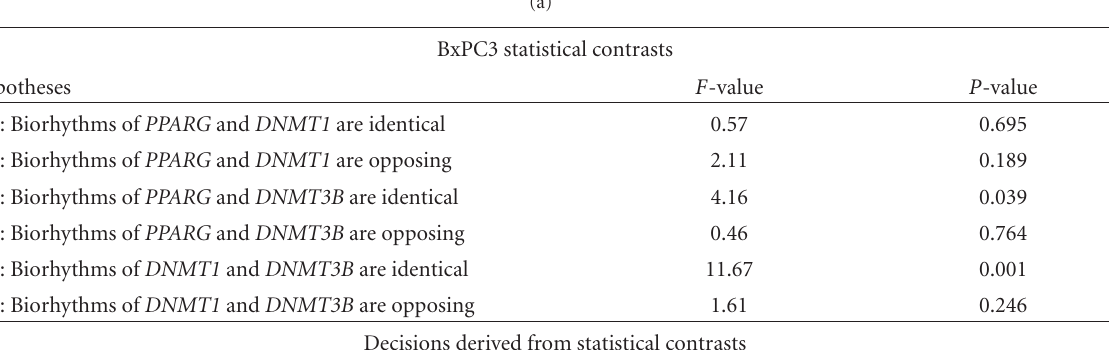
Table 2: (a) Statistical contrasts from multivariate periodic regression analysis, along with a summarization of the decision to be drawn for each comparison, (b) interpretation rules: conclusions to be drawn from the joint hypotheses testing “identical biorhythms” (H 01 ) and “opposing biorhythms” (H 02